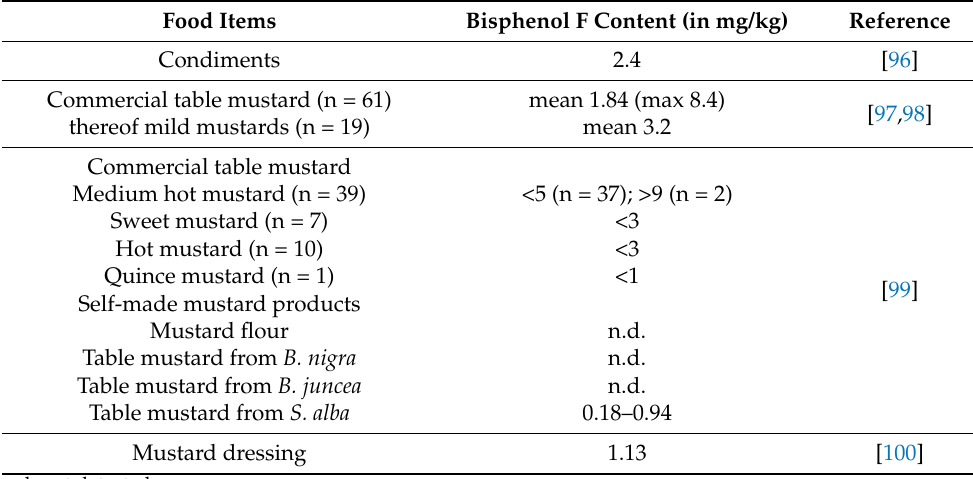
Table 3. Occurrence of bisphenol F in foods related to